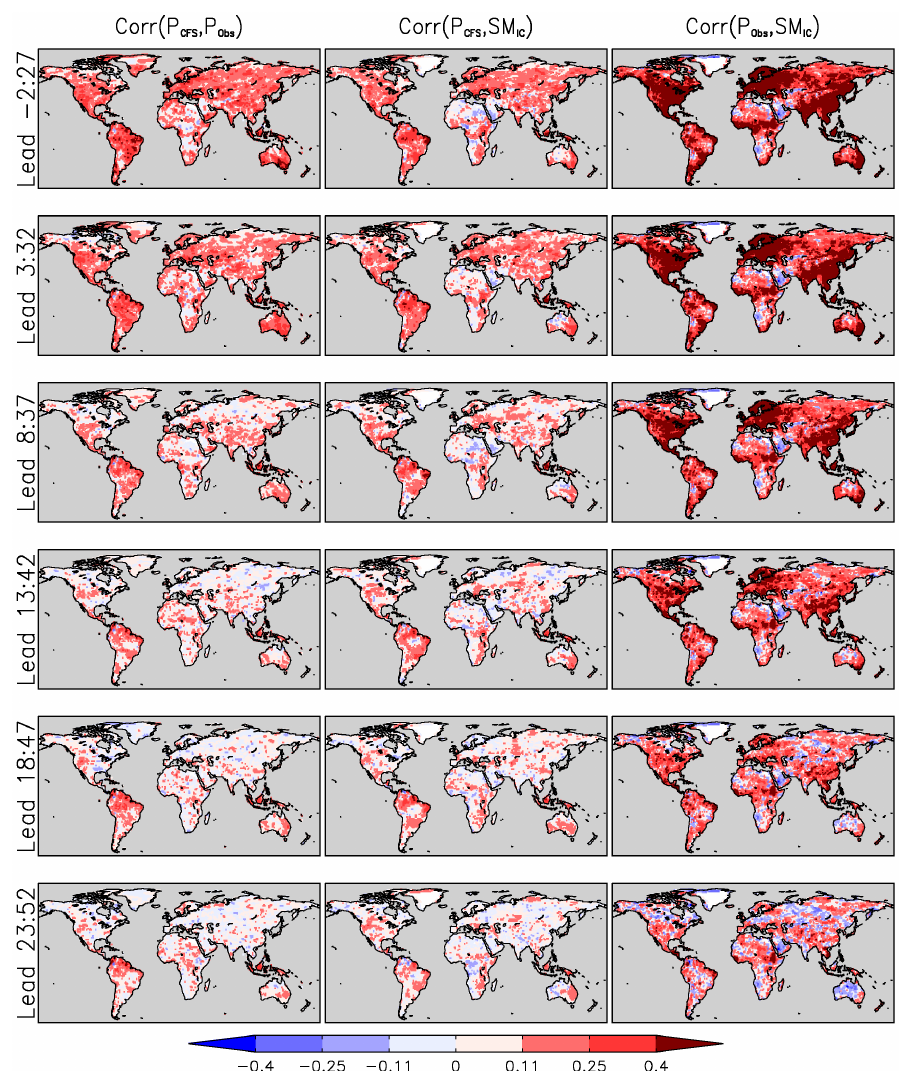
Figure 13. If, in the real world, land surface variations (e.g., in soil moisture) are able to affect the overlying atmosphere, and if an atmospheric model does not capture adequately this land–atmosphere feedback, the performance of the model will suffer. A forecast model that lacks this feedback likely cannot translate the information contained in soil moisture states into improved forecasts of air temperature and precipitation. With this as motivation, the panels above provide an evaluation of land–atmosphere feedback in the US operational forecast model (CFSv2). The three columns show from left to right the pair-wise correlations (i) between monthly CFSv2 reforecast precipitation ( P CFS ) and observed precipitation ( P Obs ) , (ii) between P CFS and reforecast initial soil moisture in layer 2 (10–40cm depth; SM IC ) , and (iii) between P Obs and SM IC , all for forecasts validating during June through August (JJA). The rows show the different leads (in days) considered. Dark colors (beyond ± 0.11) are significant at the 95% confidence level. The fact that observed precipitation rates are more closely related to antecedent soil moisture than are model-simulated rates suggests that the US operational forecast model underestimates land–atmosphere coupling. An improvement in the system’s simulation of coupled land–atmosphere processes could improve the accuracy of the forecasts produced. (Contact: Paul Dirmeyer. Figure taken from Dirmeyer (2013); see this reference for further